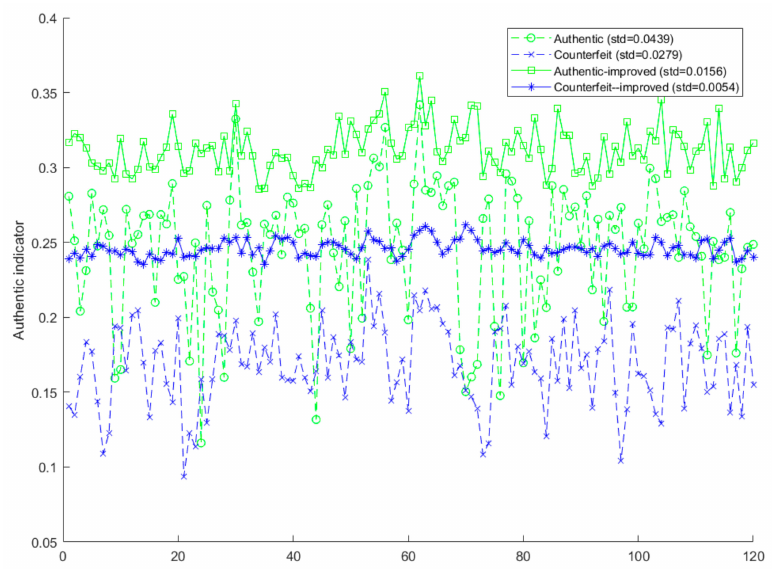
Figure 11. Authenticity indicators for authentic and counterfeit 2LQR code tag images scanned with HP Color LaserJet Pro MFP M377. The plus sign and square are authenticity indicators for authentic and counterfeit 2LQR code tag images without the improved algorithm, respectively. The circle and asterisk are authenticity indicators for authentic and counterfeit 2LQR code tag images with the improved algorithm,